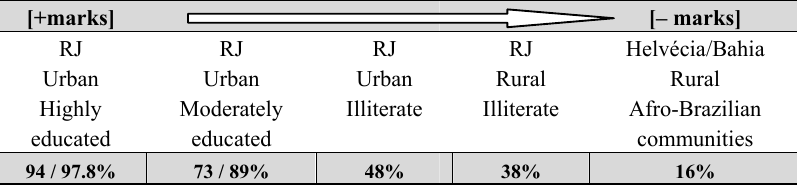
Figure 2: Continuum of third person plural verbal marks according to rural / urban features and educational levels in Brazilian varieties based on Lucchesi, Baxter & Silva